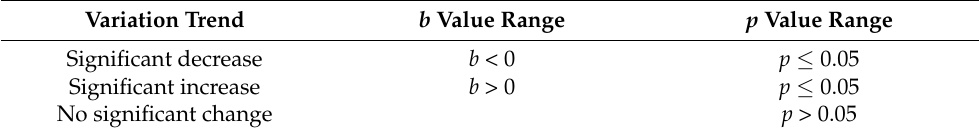
Table 2. Evaluation standard of trend